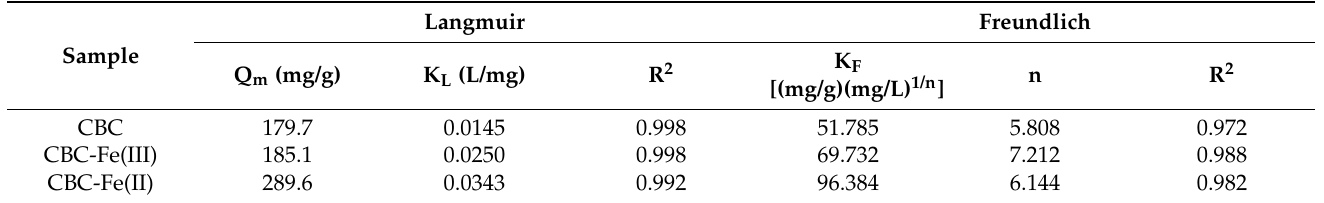
Table 4. Parameters derived from isotherms of RhB adsorption by CBC, CBC-Fe(III) and CBC-Fe(II).